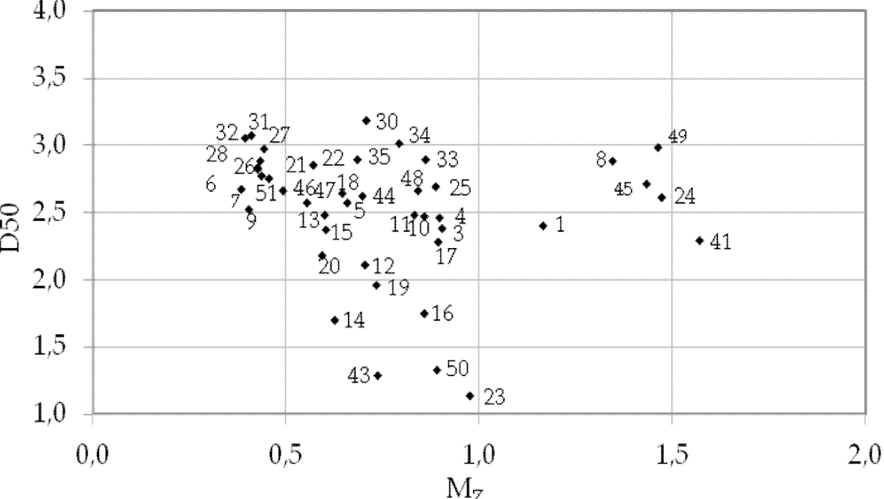
Figure 11. Summary of the average grain size (D50) and sorting (Mz) for samples collected from fields near Szamocin.